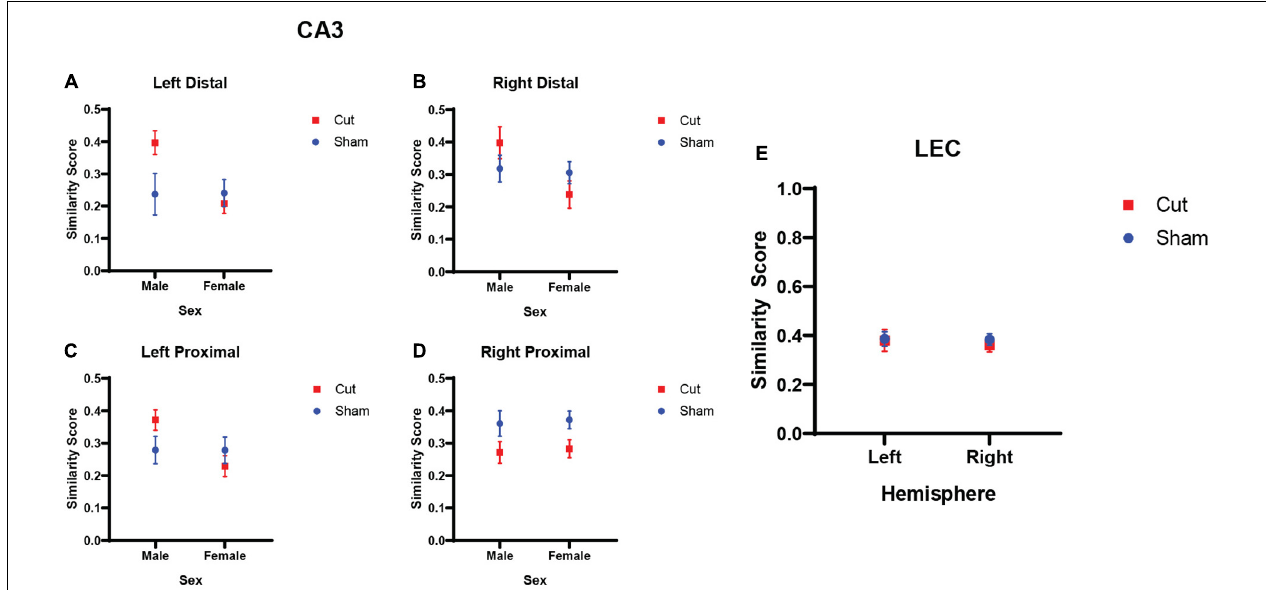
FIGURE 6 | Similarity score of population activity between epochs 1 and 2 as evaluated by Arc expression. (A–D) CA3 similarity scores did not show a main effect of hemisphere (n’s: Sham = 12